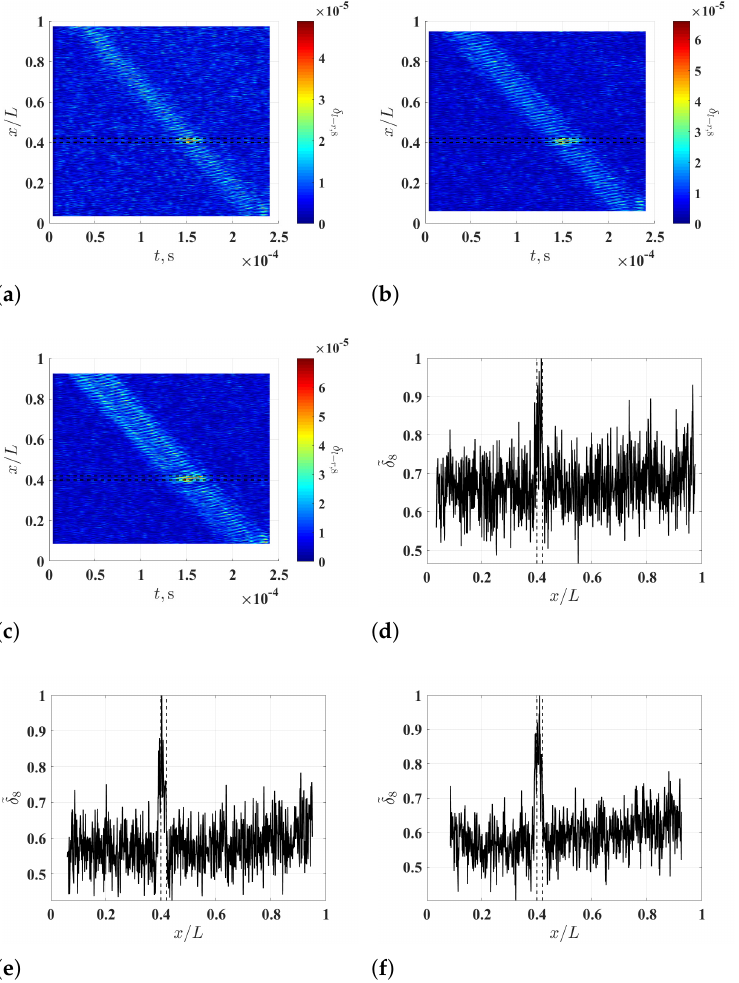
Figure 4. Multi-resolution local-regression TSCDI δ l − r , r associated with the noise-contaminated wave of the damaged beam with r = 8 and ( a ) ξ = 5%, ( b ) ξ = 10% and ( c ) ξ = 15%, and multi-resolution auxiliary TSCDI ˜ δ r with associated with the noise-contaminated wave of the damaged beam with r = 8 and ( d ) ξ = 5%, ( e ) ξ = 10% and ( f ) ξ = 15%. Locality and extent of the damage are indicated by two dashed